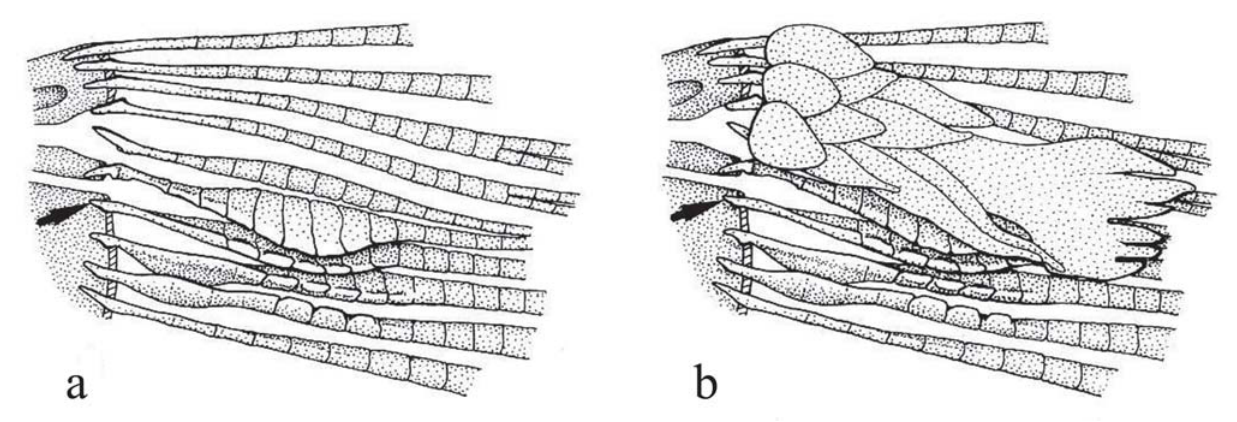
Fig. 68. Mimagoniates sylvicola , adult but still developing male, USNM 276557, 29.3 mm SL; osteology of central basal region of caudal-fin skeleton, principal fin rays 6-15, lateral view, left side, anterior at left. Principal caudal-fin ray indicated by arrow. (a) Illustrates area of fully developed caudal organ. (b) Illustrates relationship of modified dorsal-fin squamation to pump chamber skeleton. Modified from Menezes & Weitzman